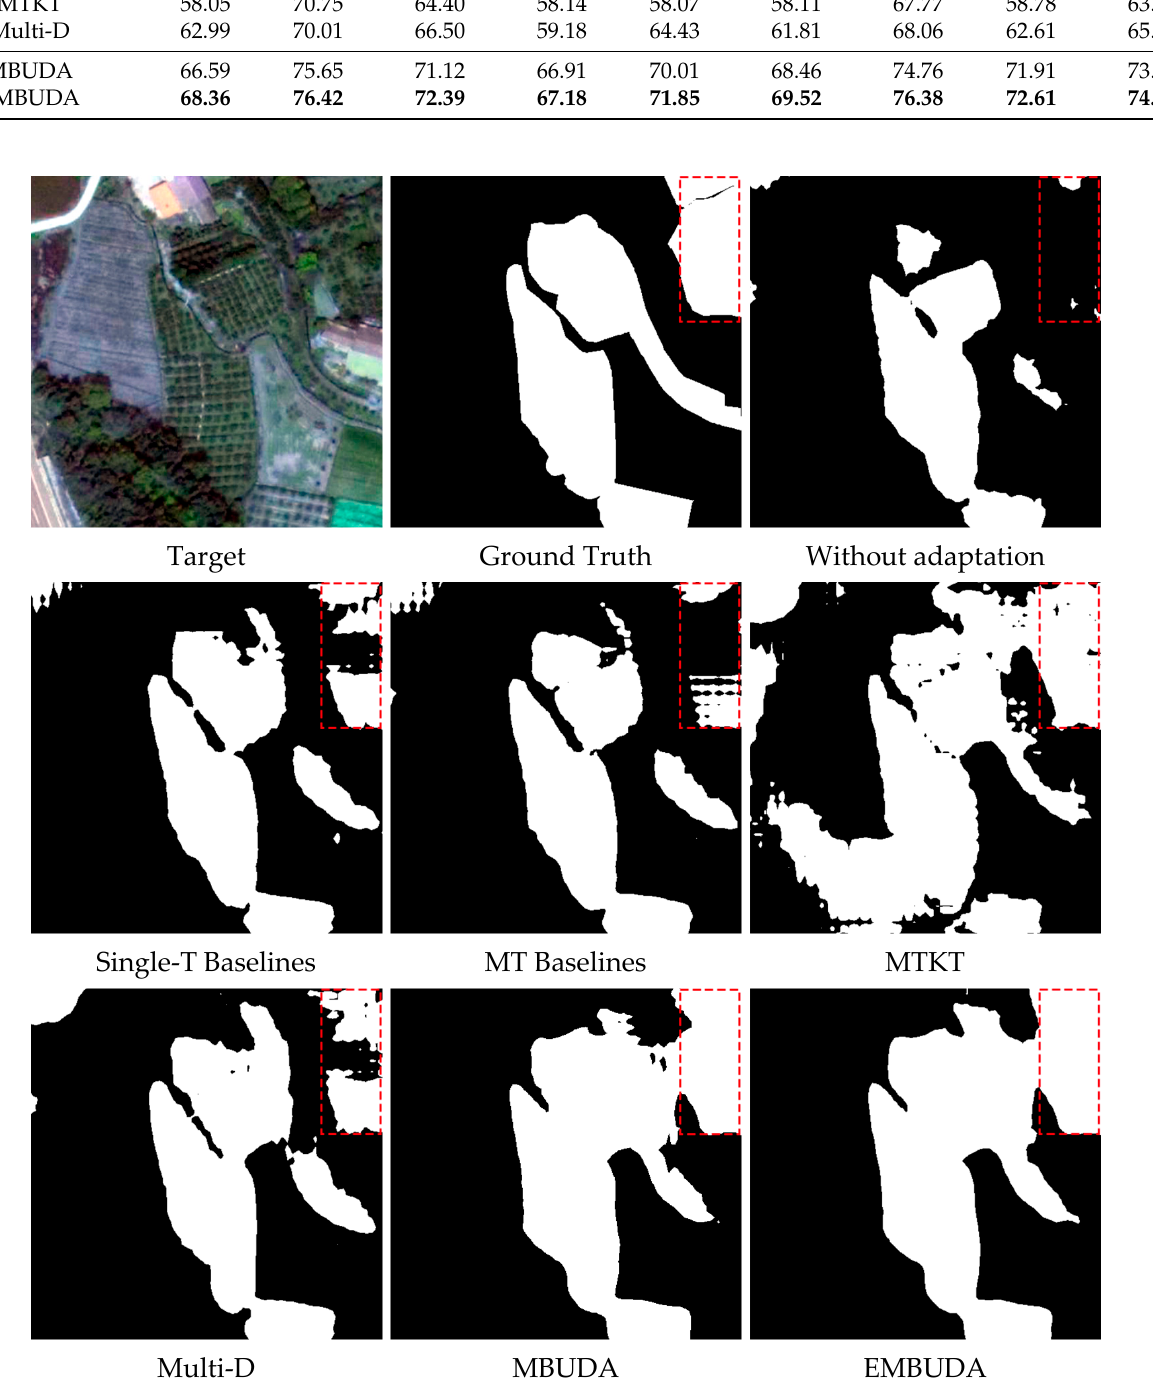
Figure 5. Outputs of orchard area segmentation in Dataset CY when adapting from Dataset ZG to Dataset CY and Dataset XT1.